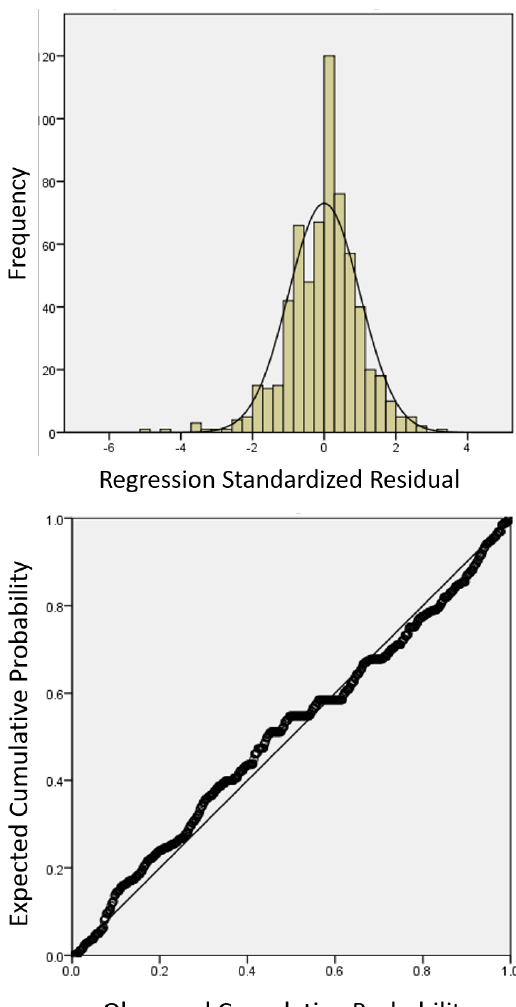
Figure 8. Histogram of standardized residuals (above) and P–P plot of standardized residuals along normal line